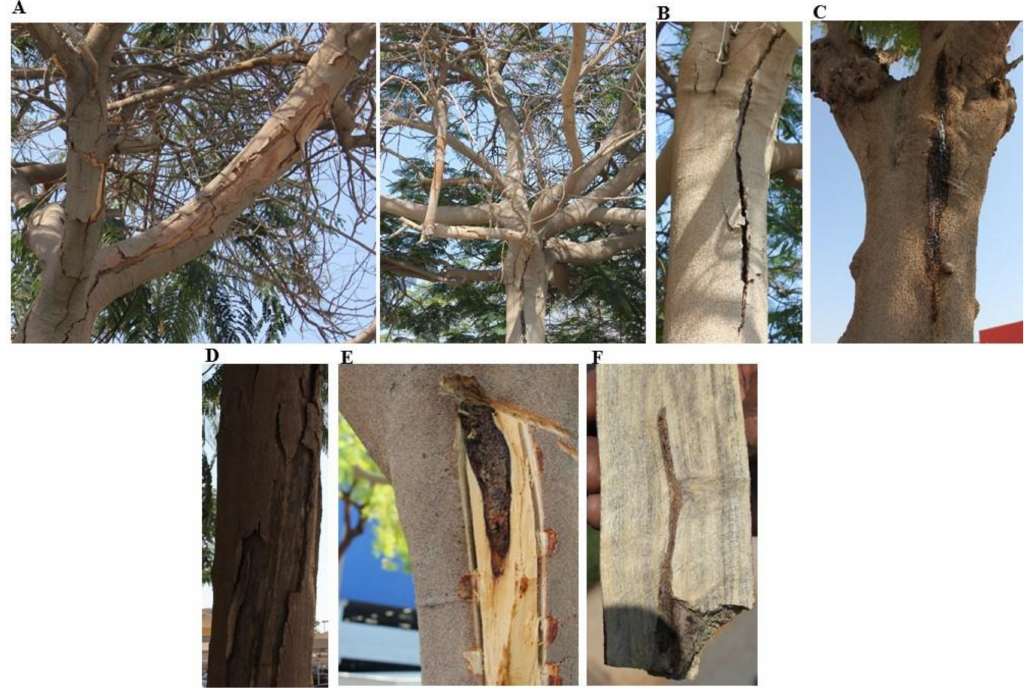
Figure 1. Symptoms of stem canker on trees of royal poinciana. ( A ) Severe symptoms of canker (left) and dieback (right); ( B ) typical longitudinal canker symptoms on stem; ( C ) gumming symptoms of the disease on the bark with fungal growth apparent beneath periderm; ( D ) main stem with the black stromata where the periderm has peeled away; ( E ) canker associated with internal symptoms in the trunk; and ( F ) a ff ected vascular tissues. In ( A–F ), naturally infested royal poinciana trees with N. dimidiatum in DFC,